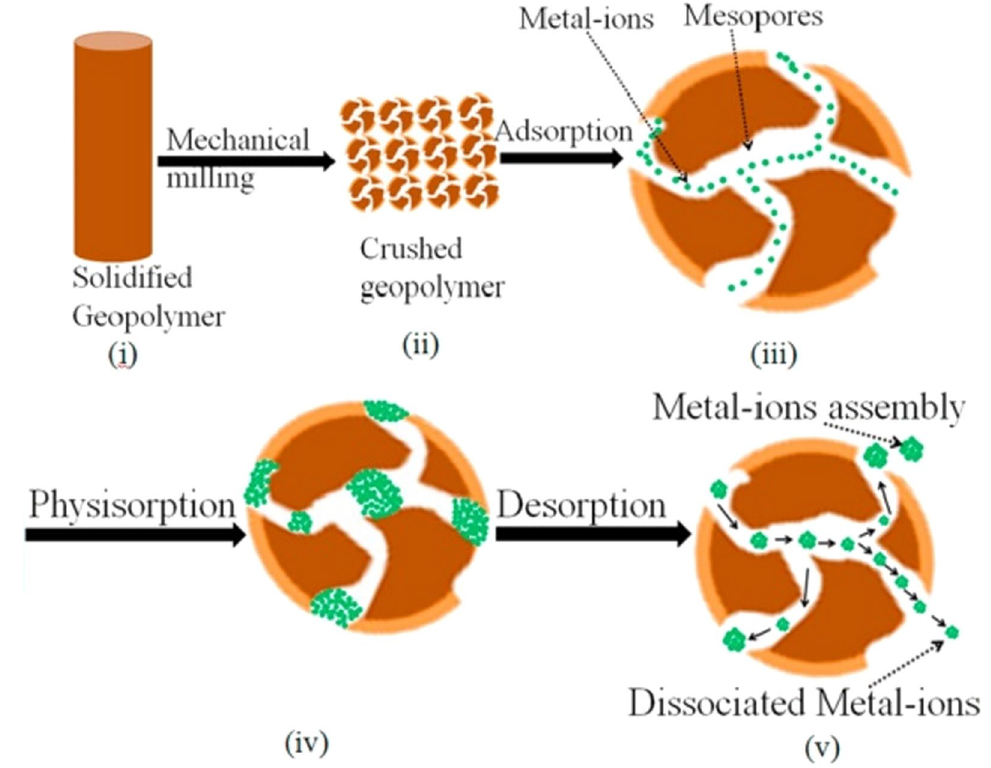
Fig. 29 Adsorption and desorption process of metal ionson the surface of geopolymer (Rasaki et al. 2019)